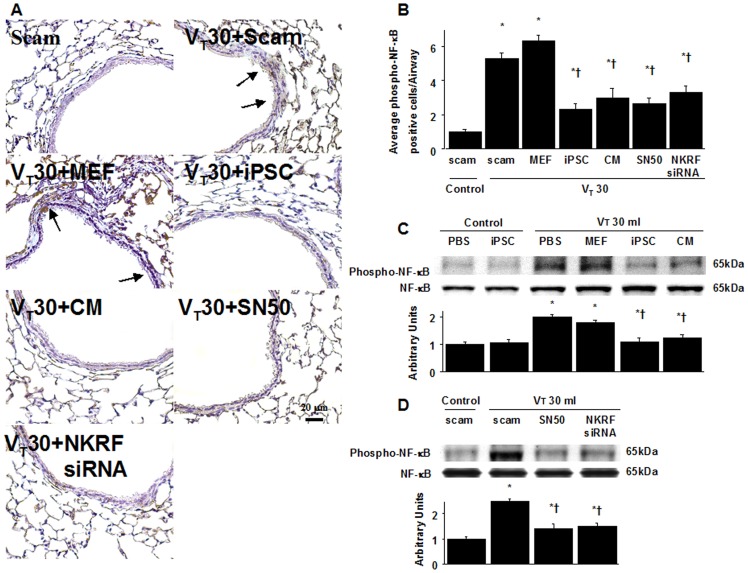
iPSCs or iPSC-CM, SN50, or NKRF siRNA suppressed lung stretch-induced NF-κB phosphorylation.NF-κB phosphorylation from the lungs of VT30-ventilated wild-type mice receiving iPSCs, iPSC-CM, SN50, or NKRF siRNA as detected by either (A, B) immunohistochemistry (×400) and quantification, (C, D) Western blot analyses. Data shown here are representative results of five independent experiments. Arbitrary units were expressed as the ratio of phospho-NF-κB to NF-κB. A dark brown diaminobenzidine signal identified by arrows indicates positive staining for phospho-NF-κB in the lung epithelium or interstitial, whereas shades of bluish tan signify nonreactive cells. Data shown here are the mean ± SD of five independent experiments. *P<0.05 vs. Non-ventilated control treated with scam, †P<0.05 vs. VT30-ventilated mice treated with scam, PBS, or MEF. Scale bars represent 20 µm.